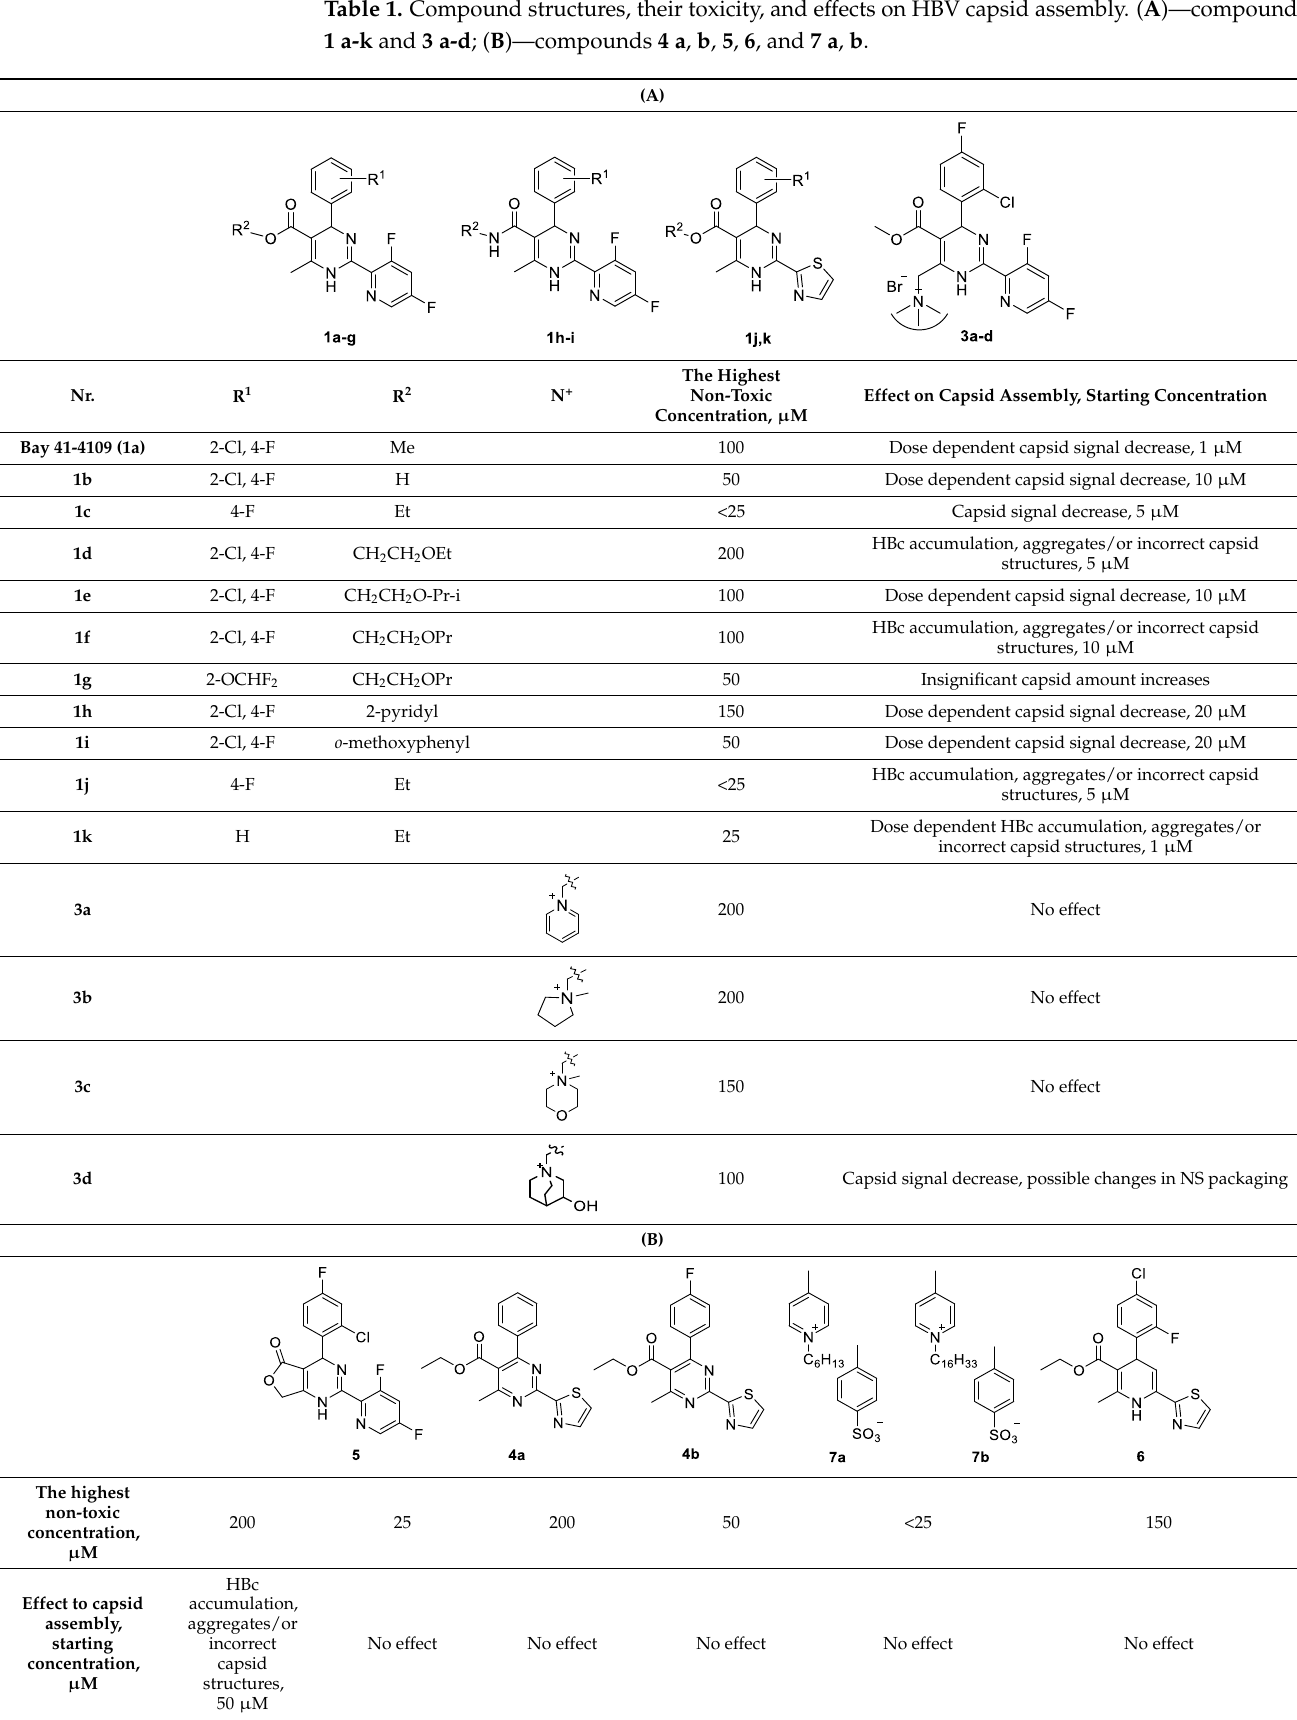
Figure 4. ( A ) Synthesis of heteroaryldihydropyridine 6 and ( B ) 1-alkyl-4-methylpyridin-1-ium 4- methylbenzenesulfonates 7 . Table 1. Compound structures, their toxicity, and effects on HBV capsid assembly. ( A )—compounds 1 a-k and 3 a-d ; ( B ) — compounds 4 a , b , 5 , 6 , and 7 a , b